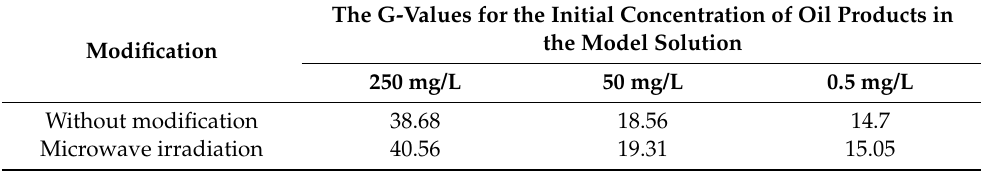
Table 3. The values of the Henry coefficients (G) for the peat sorption isotherms.